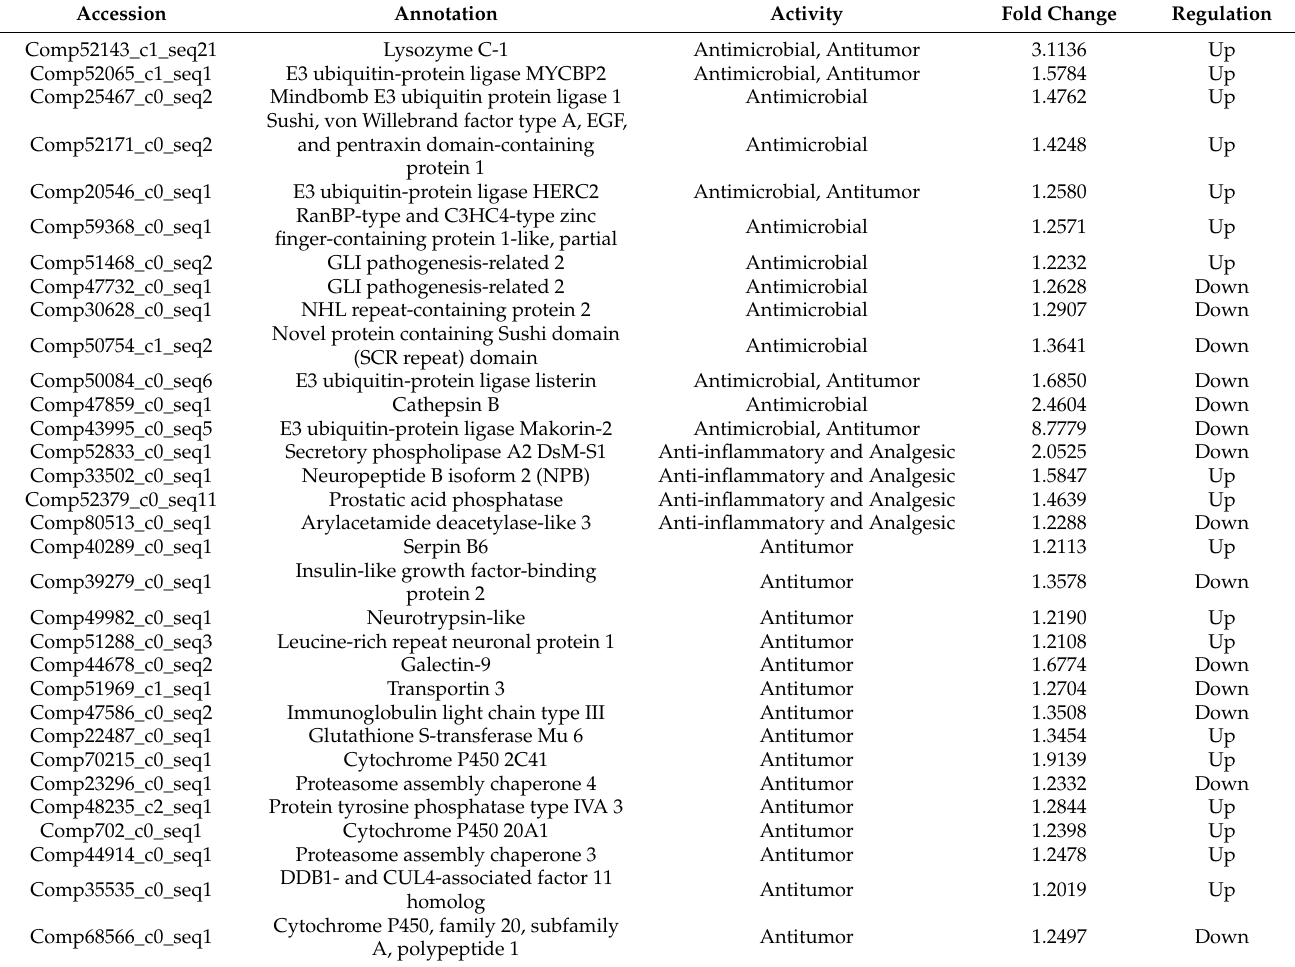
Table 1. Candidate list of potential quality markers: three types of functional